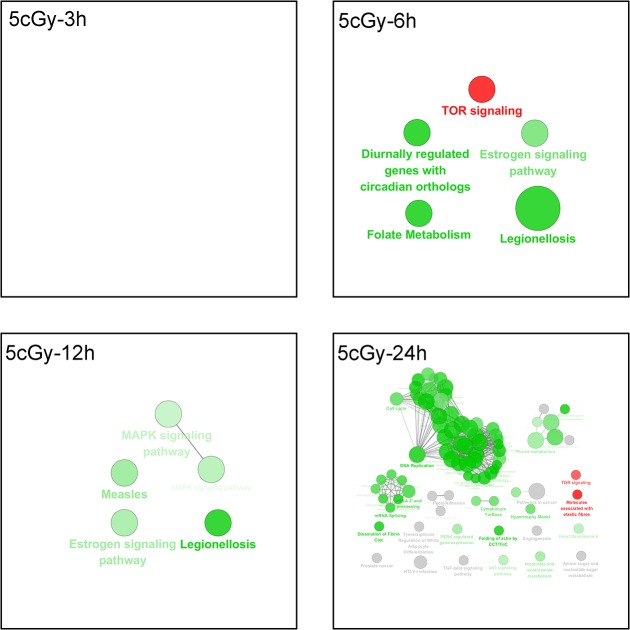
The pathway enrichment analysis results of the 5 cGy group at different time points.The KEGG, REACTOME and WikiPathways databases in ClueGO were employed for pathway enrichment analysis of each differential group gene sets acquired from microarray analyses. The Enrichment/Depletion was tested by the two-side hypergeometric test, and the Benjamini and Hochberg false-discovery rate was set to 0.05. The green and red colors code for down-regulation and up-regulation of genes, respectively, in each group. The result for 3 h post 5 cGy radiation was not shown due to absence of significant enriched pathways.